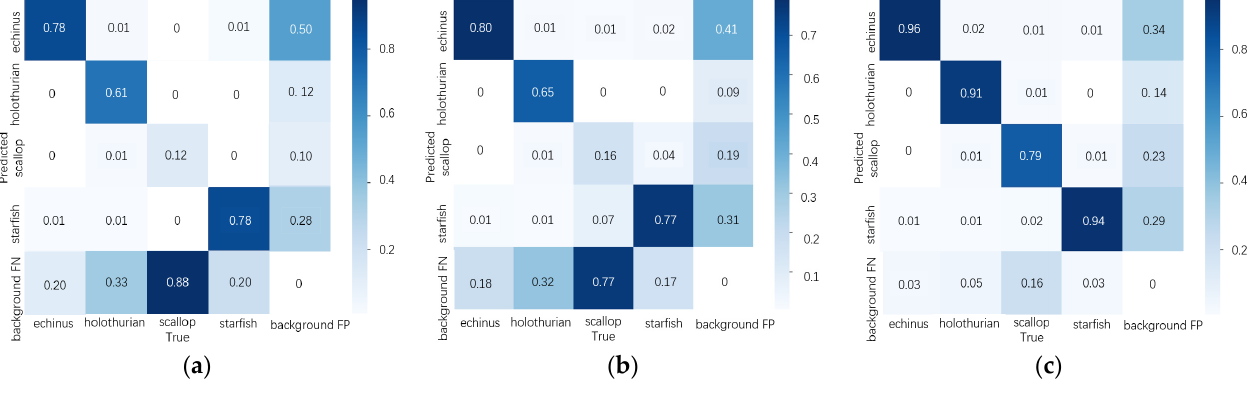
Table 4. Detection real-time comparison of proposed framework with the classical one-stage model.